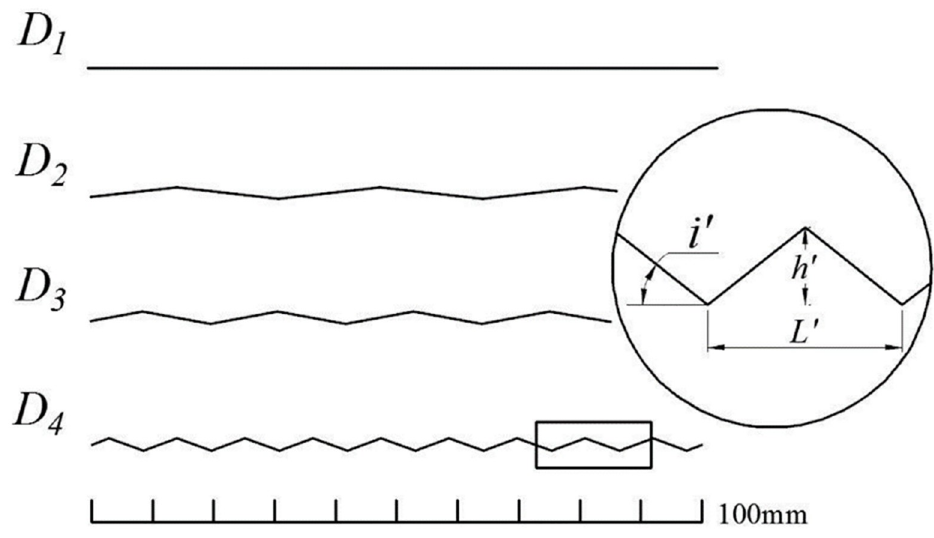
Fig 5. Design conditions and contour lines of samples D1-D4.